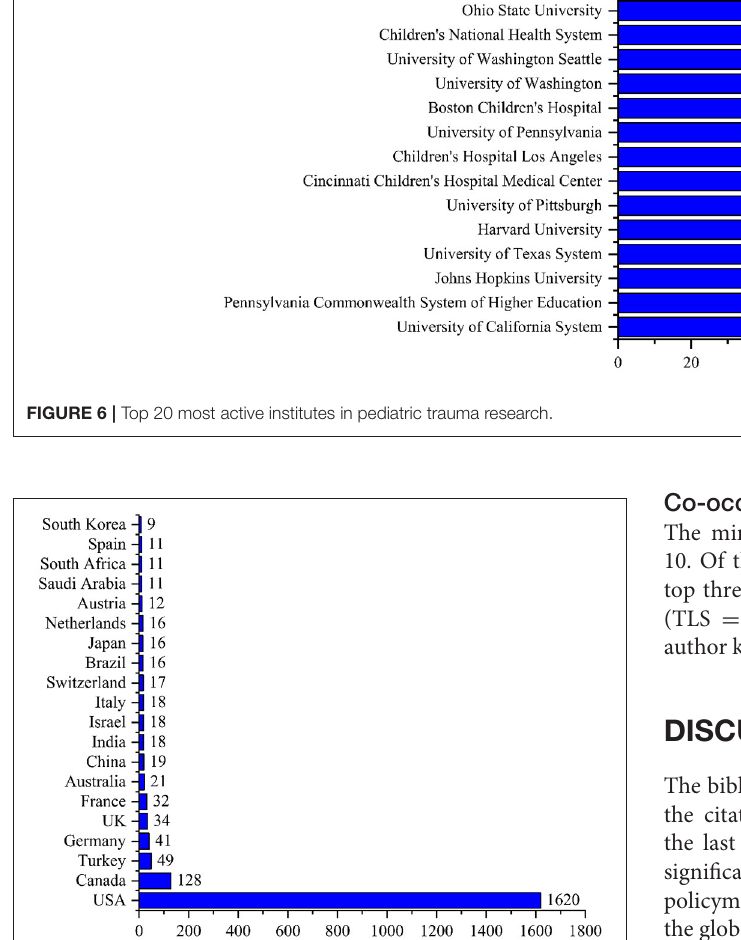
(TLS = 103), Canada (TLS = 70), and Germany (TLS = 34). in Figure 8